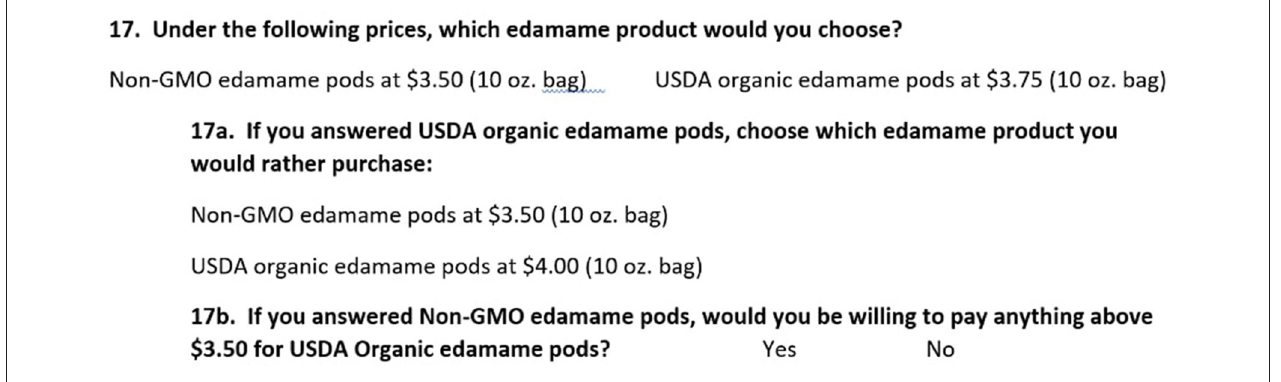
FIGURE 3 | Example of OOHB-DC questions used in survey